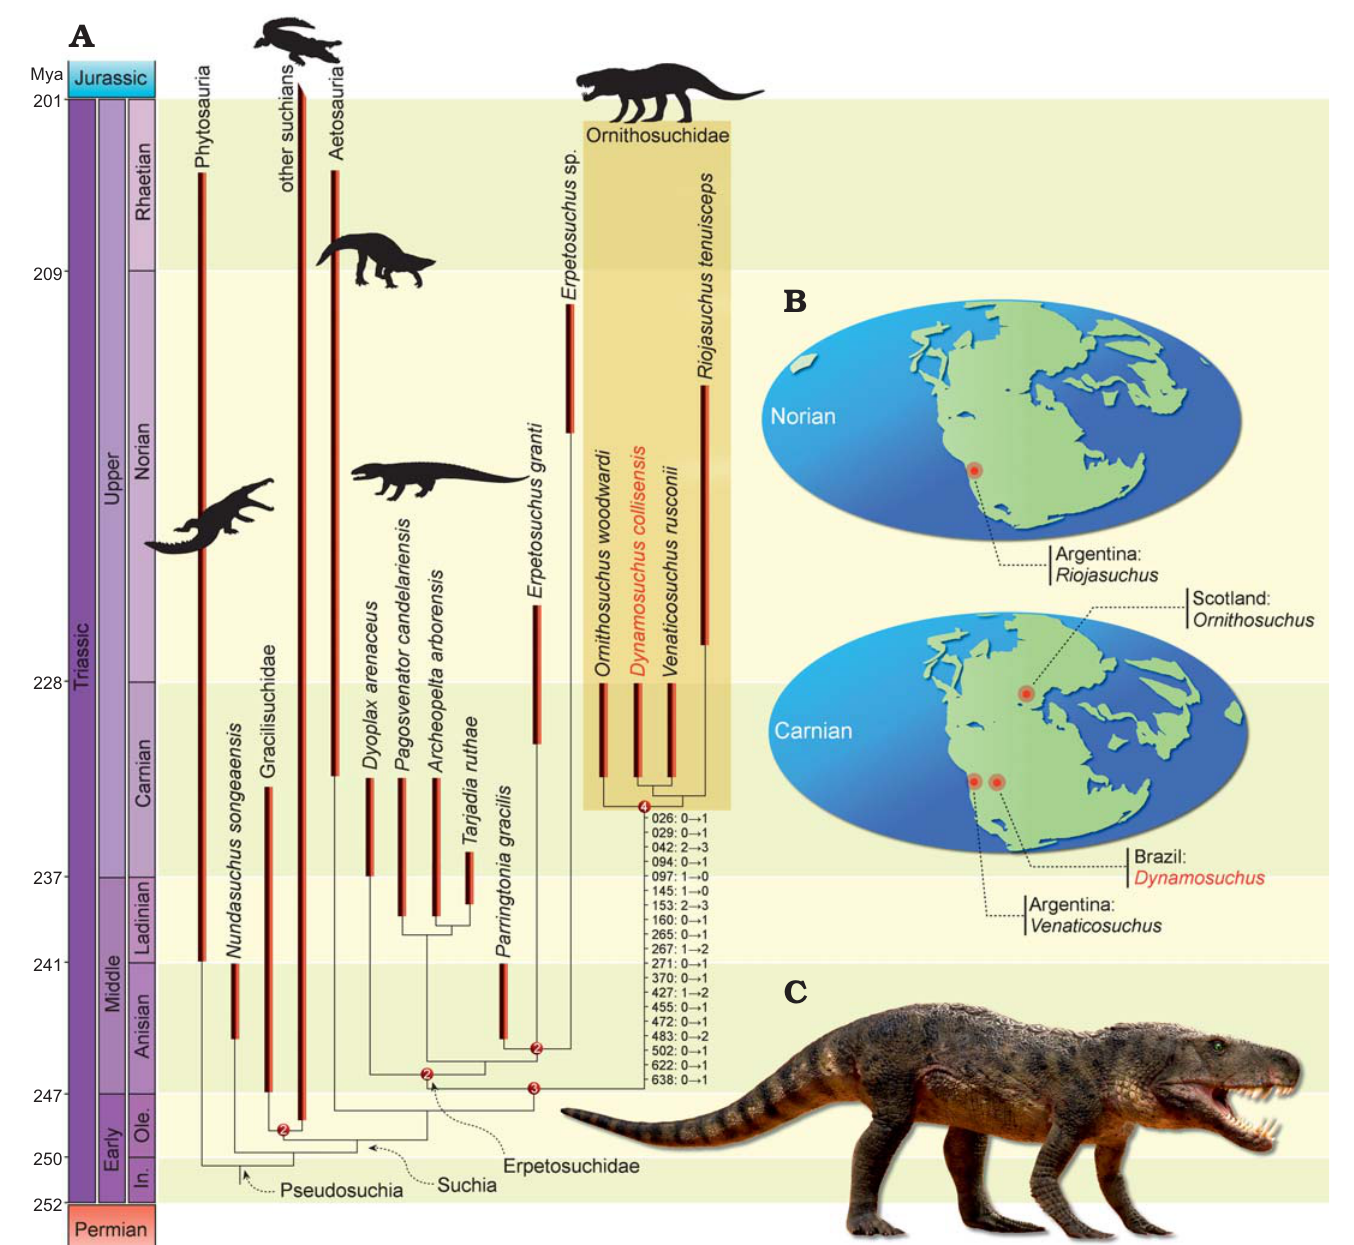
Fig. 3. Macroevolutionary patterns of Ornithosuchidae. A . Time-calibrated reduced strict consensus tree depicting the phylogenetic position of Dynamosuchus collisensis gen. et sp. nov. Numbers on nodes represent Bremer support values higher than one. Numbers associated with the ornithosuchid branch represent the characters and states that support the clade. B . Geographical distribution of ornithosuchids across the time. C . Life reconstruction of Dynamosuchus collisensis gen. et sp. nov. by Márcio L.